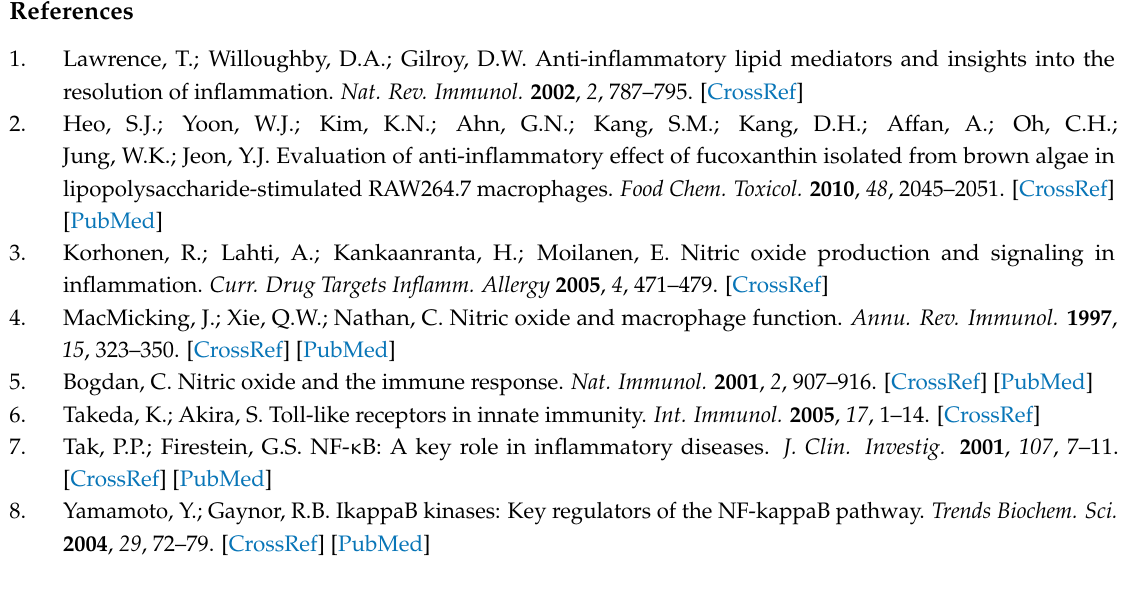
Figure S2: 13 C-NMR spectrum of catalpalactone; Figure S3: HPLC analysis of